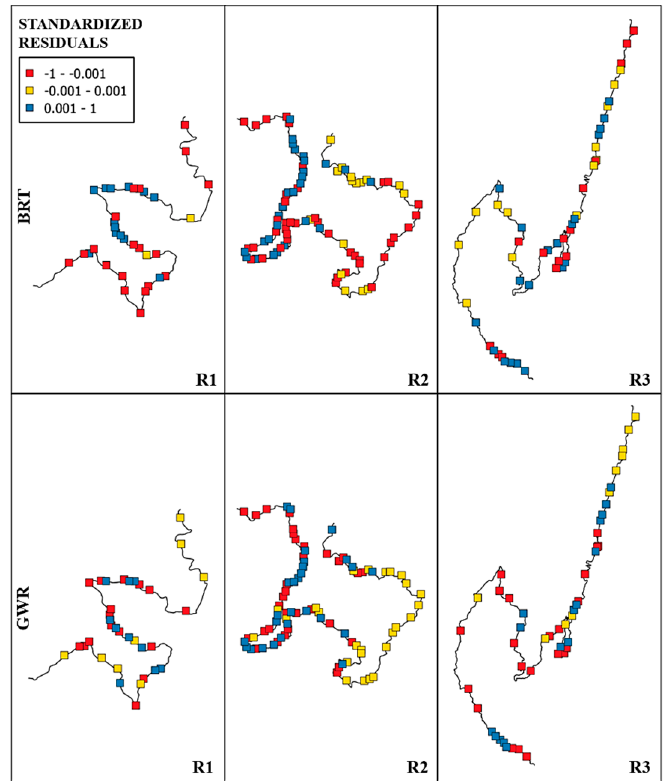
Figure 3. Spatial distribution of the mean model standardized residuals in each surveyed road of the two techniques with the best performance: BRT and GWR. Red squares are the locations with negative residuals, yellow squares are the locations with correct predictions (residuals close to zero) and blue squares the locations with positive residuals.